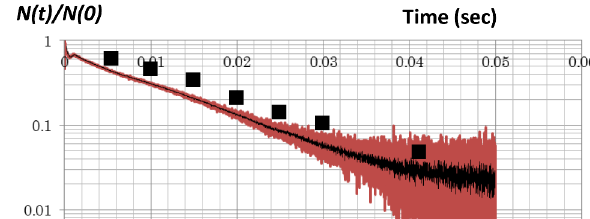
FIG. 7 (color online). Temporal evolution of the number of particles, N ð t Þ =N ð 0 Þ , experiment and calculation (rectangular points).